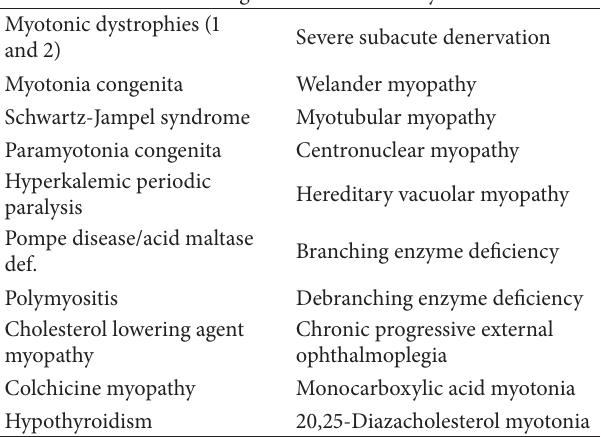
Differential diagnosis of electrical